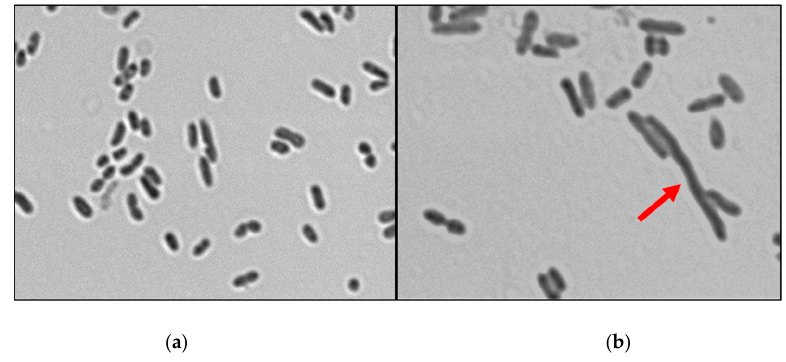
Figure 9. Confocal microscopy image obtained from E. coli bacterial cultures incubated for 4 h with PBS ( a ) or sarconesin II ( b ). Cultures were obtained after 4 h incubation at 37 °C. The arrow indicates filamentous cell